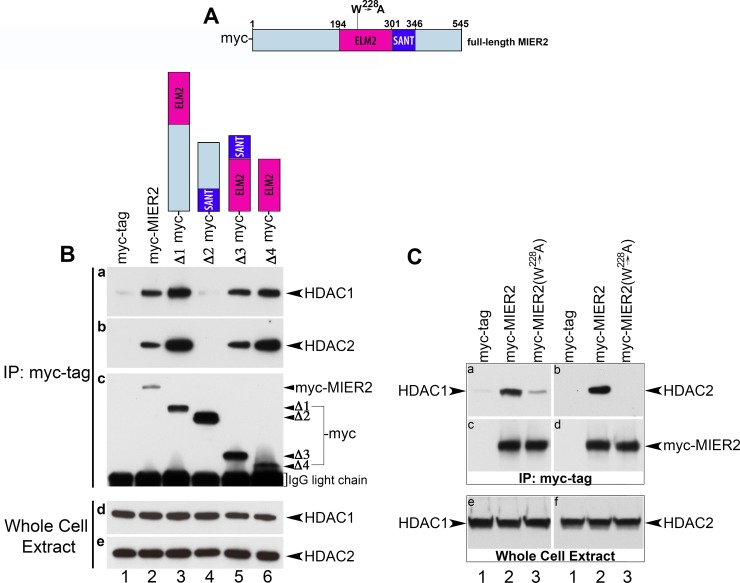
Interaction of HDAC1 and 2 with MIER2 deletion constructs.(A) Schematic showing a scaled representation of the MIER2 protein sequence, indicating the location of the ELM2 (dark pink) and SANT (dark blue) domains; the remaining sequence is colored light blue. The amino acid numbers for the beginning and end of the protein as well as beginning and end of ELM2 & SANT domains are indicated above the schematic. (B) HEK293 cells were transfected with a plasmid encoding myc tag alone (lane 1), myc-tagged full-length MIER2 (lane 2) or one of the following myc-tagged deletion constructs: Δ1 (aa1-301; lane 3), Δ2 (aa302-545; lane 4), Δ3 (aa194-346; lane 5), Δ4 (aa194-301; lane 6). Extracts were either loaded directly on the gel (panels d-e) or subjected to immunoprecipitation with the 9E10 anti-myc tag antibody. The immunoprecipitates were analyzed by Western, using either anti-HDAC1 (panel a) or anti-HDAC2 (panel b). The blots in panels a & b were stripped and restained using the 9E10 anti-myc tag antibody to verify the presence of the relevant MIER2 deletion construct in the immunoprecipitates; the restained blot from panel a is shown in panel c. The blots in panels d & e were stained with anti-HDAC1 or anti-HDAC2, respectively, to verify equivalent HDAC levels in the cell extracts. A schematic illustrating the MIER2 sequence included in the deletion construct used is shown above each lane. (C) HEK293 cells were transfected with a plasmid encoding myc tag alone (lane 1) or myc-tagged -wild-type MIER2 (lane 2) or -MIER2 containing a point mutation, 228W→A, in the ELM2 domain. Analysis was performed as in (B).